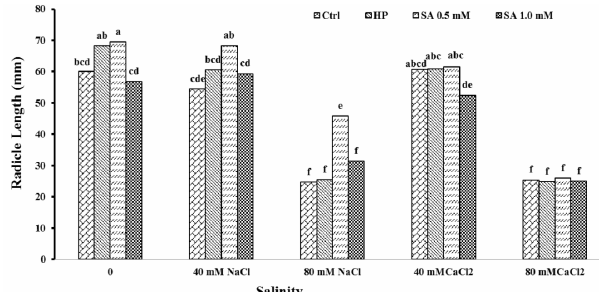
Fig. 1. Mean comparisons of the interaction of priming and salinity on radicle length of milk thistle. Ctrl: control (no priming), HP (hydro priming), SA (salicylic acid). Different letters on columns refer to significant differences between treatments at 5 % level according to LSD Test